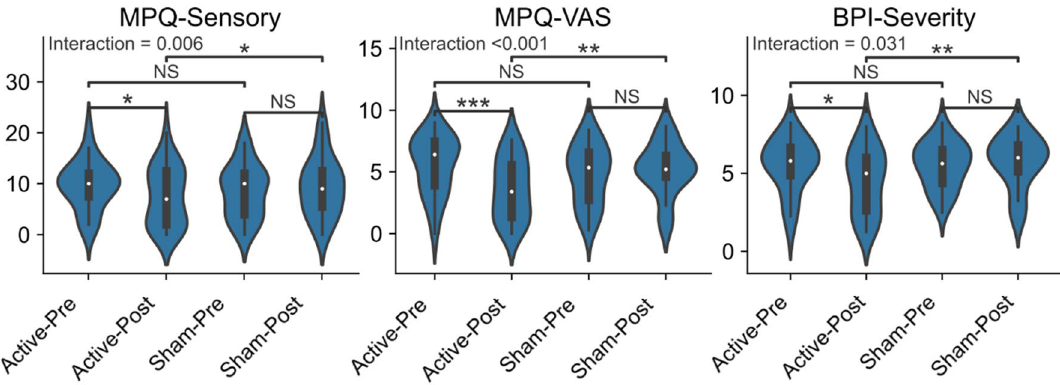
Figure 1. Active M1-rTMS is superior to sham in relieving clinical pain. Time × Treatment interaction in MPQ-Sensory was tested using Friedman’s ANOVA with Wilcoxon–Nemenyi–McDonald–Thompson post- hoc tests. All p-values are corrected for 4 preplanned contrasts. BPI Brief Pain Inventory, MPQ McGill Pain Questionnaire, NS not significant, VAS visual analog scale; *p < 0.05; **p < 0.01; ***p <